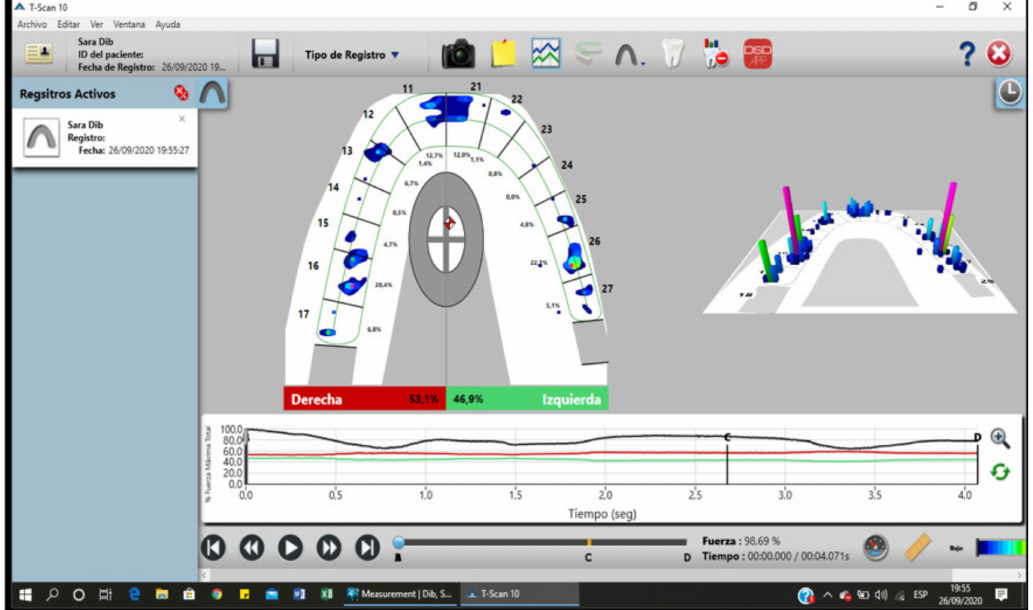
Figure 4. Digital occlusal analysis determining the characteristics of the jaw